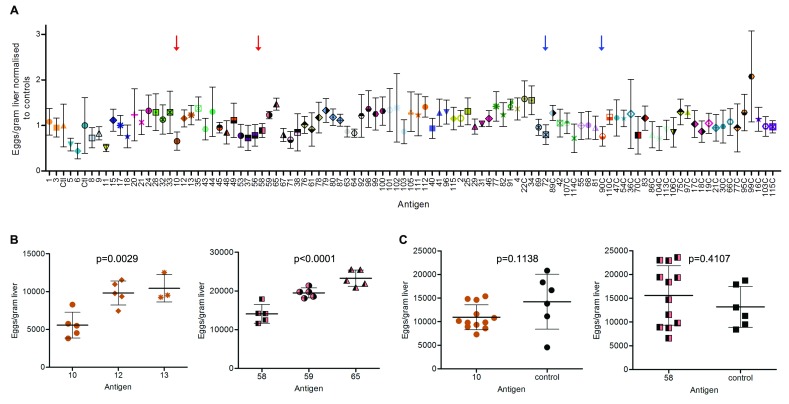
Systematic challenge of animals immunised with
Schistosoma mansoni antigens does not identify strongly protective candidates.(
A) An overview of the 36 cohorts of immunised animals challenged with
S. mansoni cercariae. Each cohort is represented by a different colour and is composed of two or three groups of animals. For each group of immunised animals, the average number of eggs per gram of liver has been normalised to the average number of eggs per gram of liver of the PBS-immunised controls from the same cohort. Red or blue arrows indicate groups of animals that showed statistically significant difference from two or one group of the same cohort, respectively. Datapoints are mean ± SD;
n = 5 or more animals per group, with the exception of proteins 17, 18C, 28, 40, 55, 56, 64, 66C, 69, 81, 87, 99C and 102 (
n = 4), and proteins 13, 17C and 42 (
n = 3) due to premature mortality. (
B) Details of individual datapoints in cohorts corresponding to antigens 10 and 58, for which a statistically significant difference in the number of eggs per gram of liver was observed by ANOVA analysis compared to the other groups from the same cohort (p=0.0029 and p<0.0001, respectively). Bars are mean ± SD;
n = 5 animals per group, with the exception of protein 13 due to premature mortality. (
C) Repeat experiments with antigens 10 and 58 on larger cohorts of animals shows no statistically significant difference between animals immunised with the antigen of interest (
n = 12) compared to animals who received PBS (
n = 6). Individual datapoints are shown. Bars are mean ± SD.